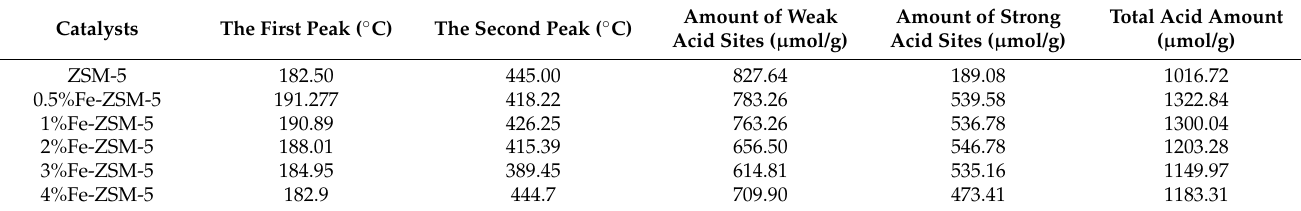
Figure 5. NH 3 -TPD profiles of Fe-ZSM-5 with different Fe loadings. Table 2. The acid strength and total acid amount of Fe-ZSM-5 with different Fe loadings.